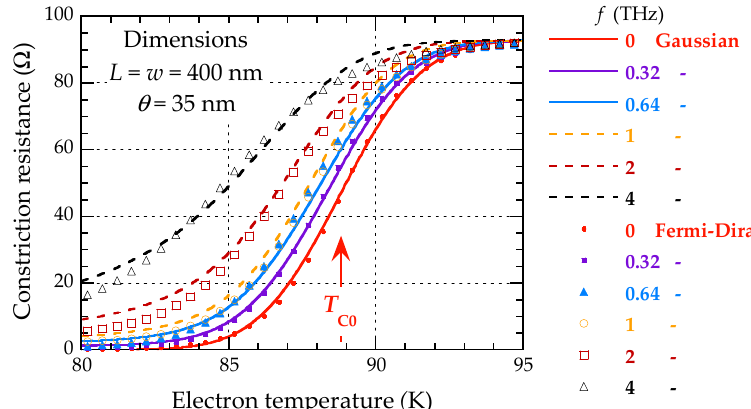
Figure 3. Frequency-dependent YBCO superconducting transition illustrated by the constriction resistance vs. frequency. The DC plot ( f = 0) is a fit from experiment [30]. The gaussian curves describe the T C distribution as discussed in the text. Fermi-Dirac fits have been used for the device performance simulation as more appropriate to the convergence of numerical solutions. Redrawn after [27].